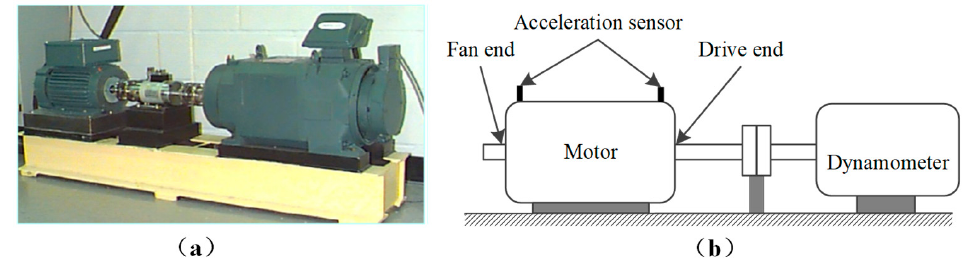
Figure 6. The CWRU bearing test device. ( a ) Physical experimental devices, ( b ) Structural schematic.